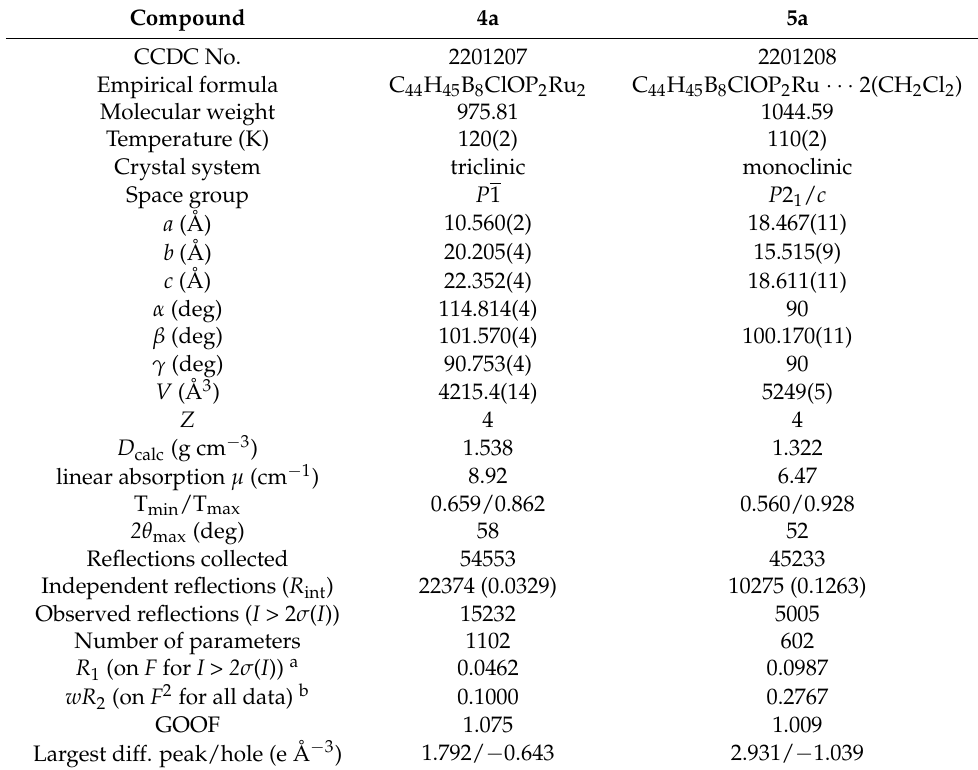
Table 2. Crystal data, data collection and structure refinement parameters for 4a and